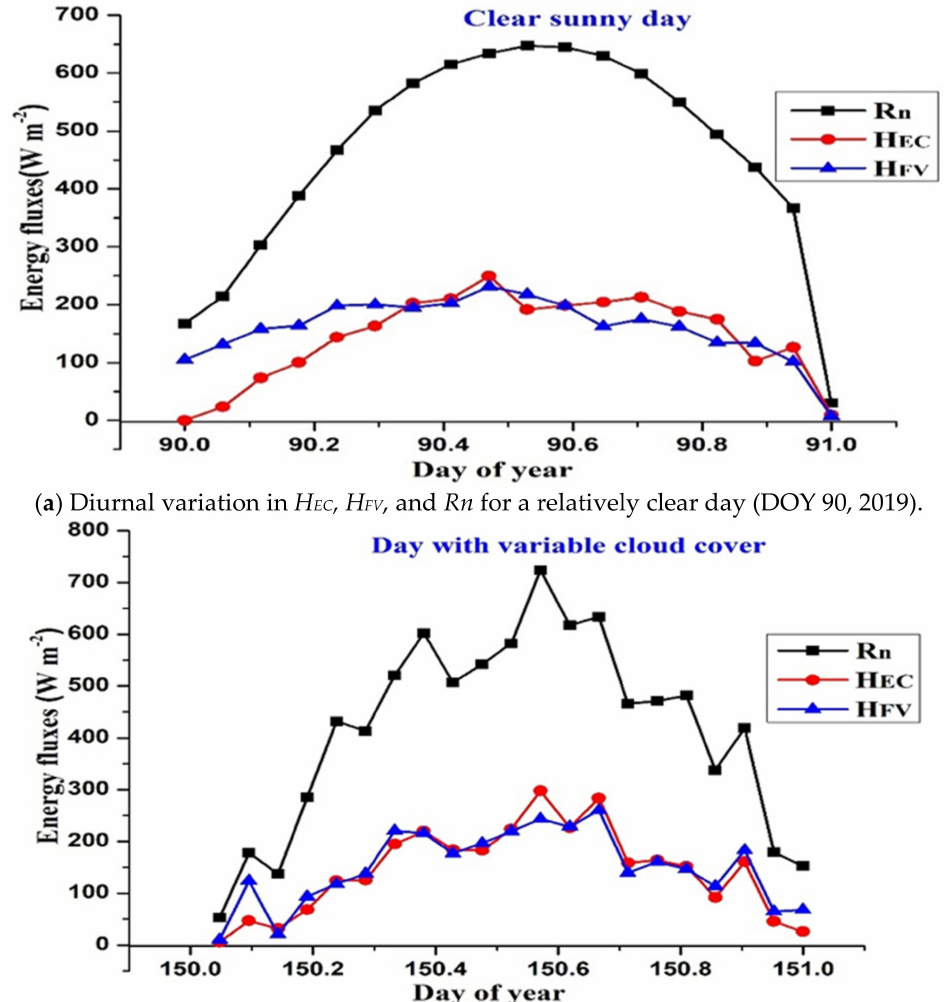
Figure 7. Diurnal variation in the half-hourly dataset of H EC and H FV, along with the Rn for ( a ) a clear day (DOY 90, 2019) and ( b ) day with variable cloudiness (DOY (150,